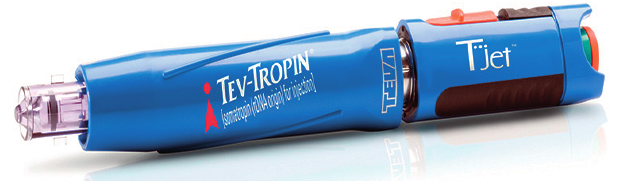
Figure 11. Commercially available jet injector Tjet ®